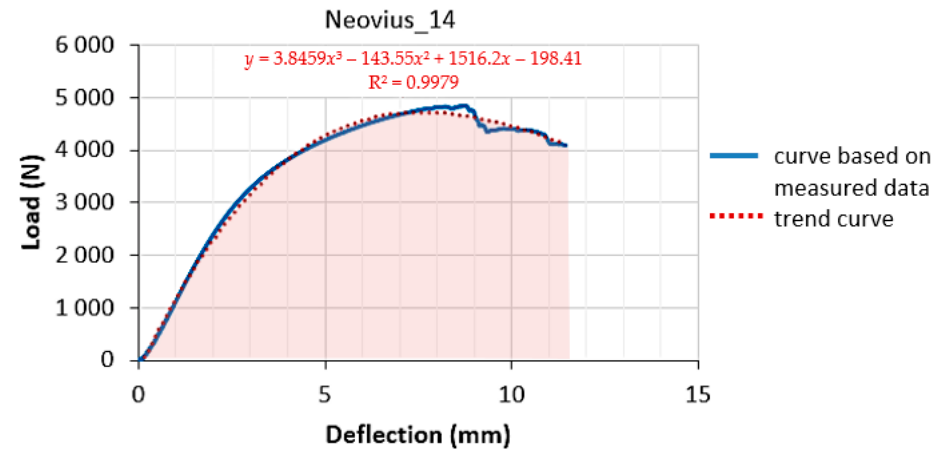
Figure 8. Calculation of energy absorption based on the force-de fl ection curve.